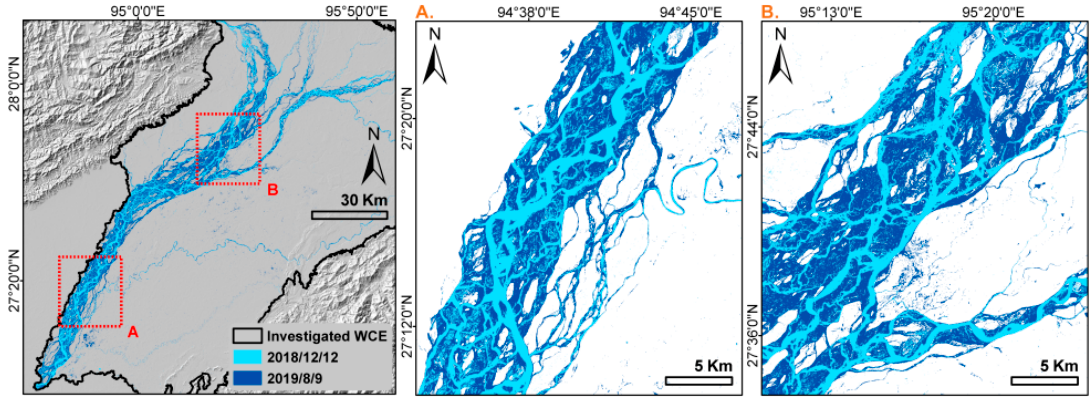
Figure 15. The maximum (2019/8/9) and minimum (2018/12/12) flooded area of the Brahmaputra River during the sensing period detected by the Sentinel-1 SAR imagery using the decided Otsu’s threshold value.